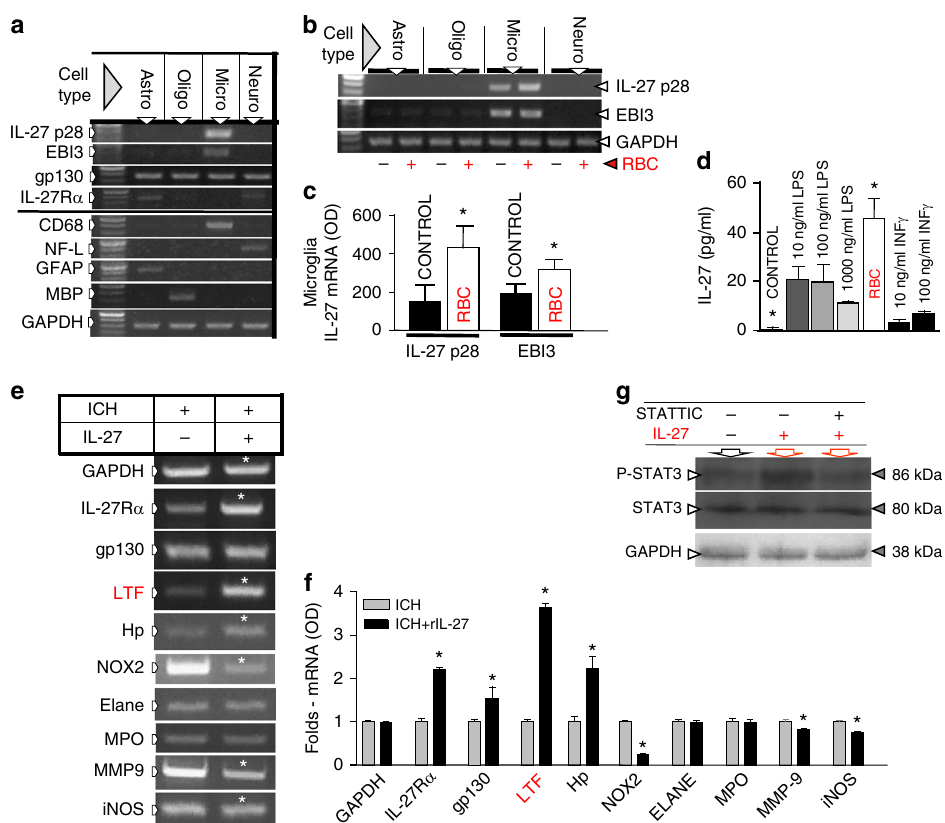
Fig. 2 Microglia-derived IL-27 causes neutrophil polarization. Cell-speci fi city of IL-27 and IL-27R expression in the SD rat brain cells ( a – d ), and the gene expression pro fi le ( e , f ) in IL-27-modi fi ed mouse BM-PMN precursors, and g STAT3/pSTAT3 protein in rat BM-PMN exposed to rIL-27, in vitro. a Photograph of representative gels demonstrating IL-27 p28 and EBI3 mRNA and IL-27R α mRNA and gp130 mRNA expression in primary rat brain microglia (micro, identi fi ed with CD68), neurons (neuro, identi fi ed with neuro fi lament L, NF-L), astrocytes (astro, identi fi ed with glial fi brillary acidic protein, GFAP), and oligodendrocytes (oligo, identi fi ed with myelin basic protein, MBP) in culture. IL-27 p28 and EBI3 are exclusively expressed by microglia. The gp130 is expressed by all cell types, while IL-27R α is mainly by astrocytes and neurons. GAPDH was used as an internal control. b , c Representative RT-PCR gels and bar graph of IL-27 p28 and EBI3 mRNA expression in rat brain cells in response to RBC. IL-27 p28 and EBI3 are upregulated in rat microglia (Micro), but not in astrocytes (Astro), oligodendrocytes (Oligo) or neurons (Neuro) at 6 h after exposure to RBC. The data were calculated as mean ± SEM, n = 4 – 6. * p ≤ 0.05 (using paired t -test), compared with the media control group (without RBC). GAPDH was used as an internal control. d IL-27 p28 protein determined with ELISA in rat microglial culture medium at 6 h after exposure to RBC, LPS, and interferon gamma (IFN γ ). * p ≤ 0.05, compared with the control group ( n = 3), established using one-way ANOVA followed by Newman – Keuls post-test. e Photograph of RT-PCR gels and f bar graph demonstrating the gene expression pro fi le in the PMNs harvested from mouse BM-PMNs at 24 h after ICH and then cultured in 10% mouse serum in RPMI1640 and treated with recombinant mouse IL-27 (150 pg/ml) or saline for 24 h, in vitro. The analyzed genes included: iNOS, MMP-9, NOX2, Hp, LTF, myeloperoxidase (MPO), neutrophil elastase (ELANE), and GAPDH. Data were expressed as mean ± SEM ( n = 3 – 5). * p ≤ 0.05, compared with the vehicle- treated group, established using paired t -test. g Photos of immune Western blotting of phosphorylated form (pSTAT3) and total STAT3 protein in puri fi